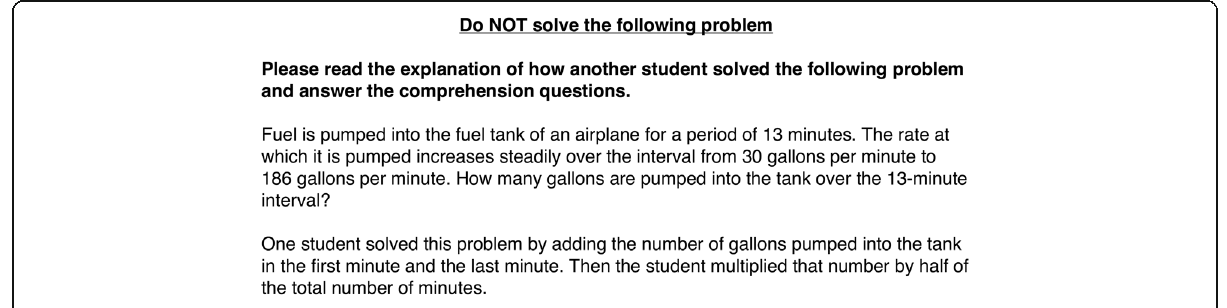
Fig. 3 Description of the Gauss strategy from the exposure section of the